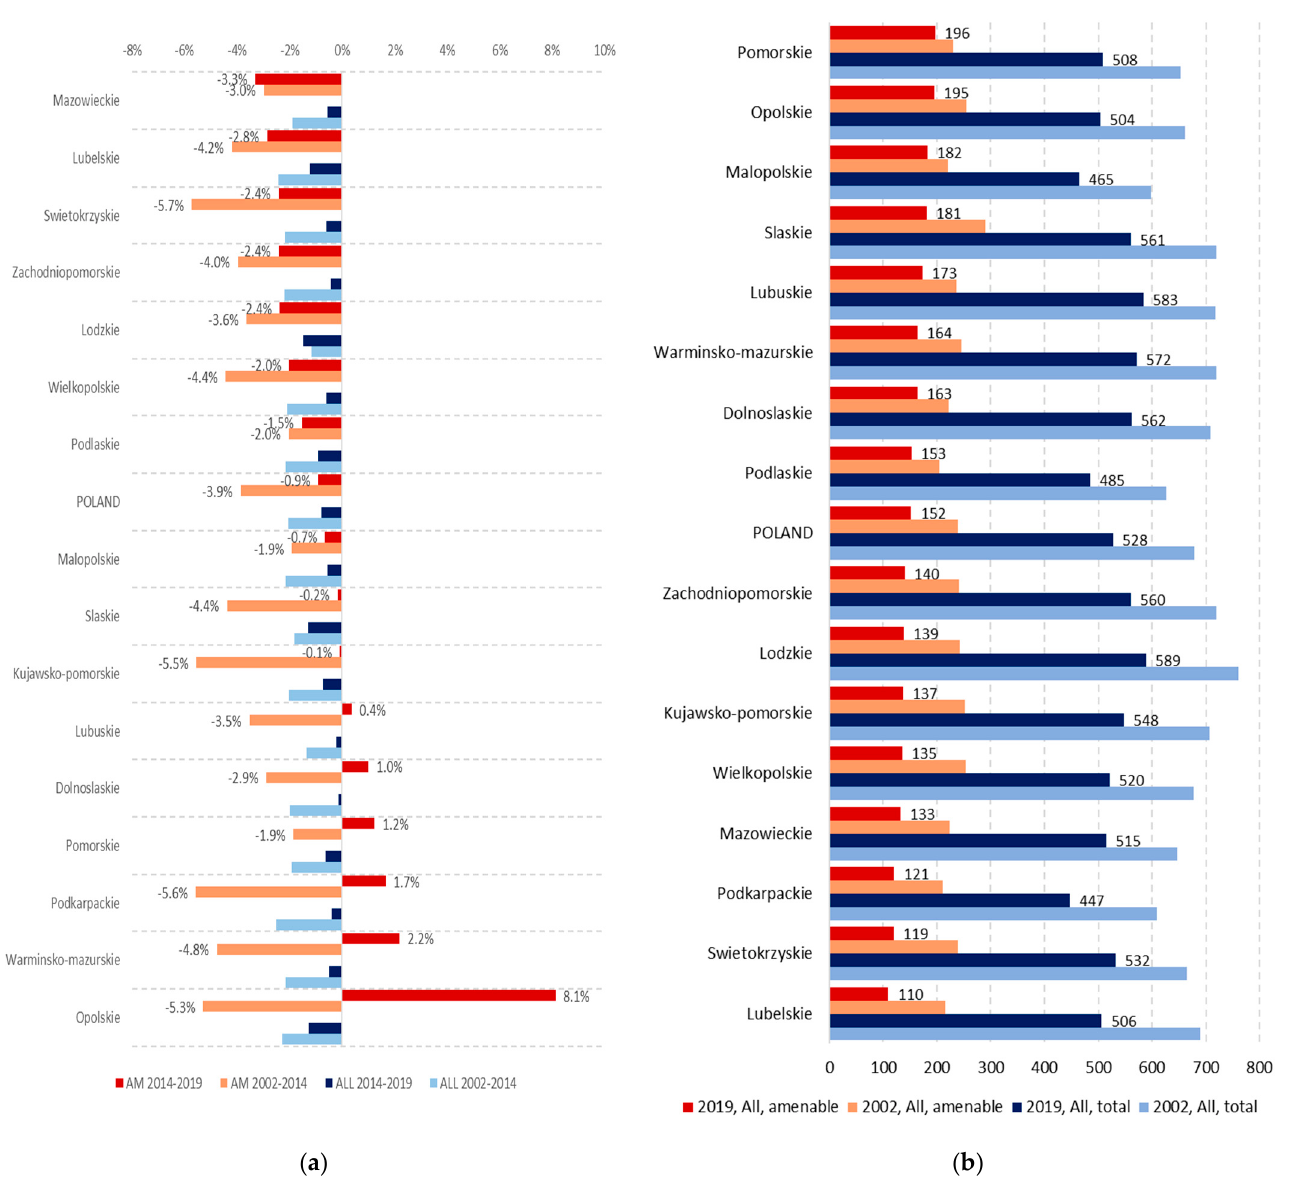
Figure 3. Total and amenable mortality, 2002–2019: ( a ) change in total and amenable mortality (AAPC, both sexes) by region in 2002–2014 and 2014–2019 (data labels only shown for amenable mortality for reasons of space); ( b ) total and amenable mortality (standardised rates per 100,000, both sexes) by region in 2002 and 2019.